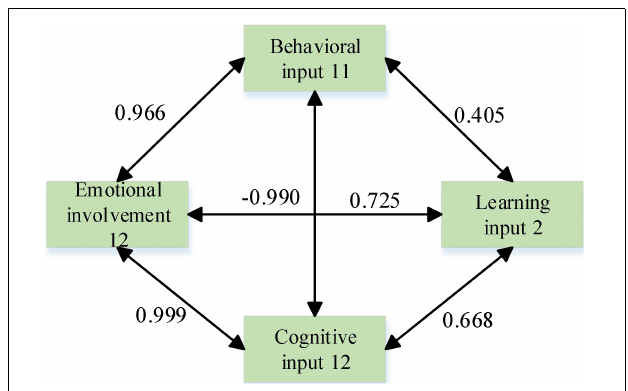
FIGURE 4 | Path diagram of English